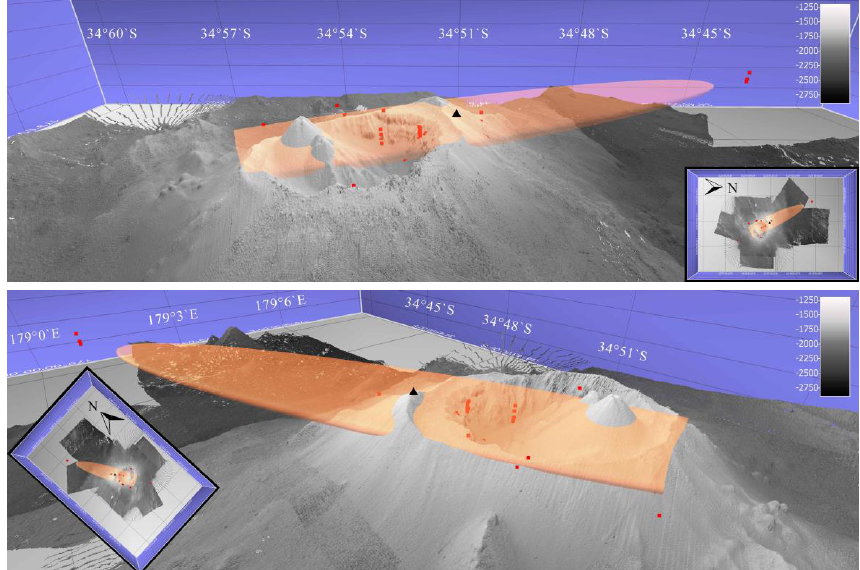
Figure A1. Local bathymetry of Brothers volcano (2-fold exaggeration) with the calculated plume ellipsoid. The two panels mark in orange color the ellipsoid based on excess 223 Ra activity above background. The red dots indicate sample locations with Ra activity above background, which were used for the ellipsoid calculation. The black triangle in each panel marks the mean latitude and longitude location of plume samples (depth not representative for display reasons), which was used as ellipsoid center. The direction of view in the first panel is westward, and northeastward in the second panel. Local bathymetry from Koschinsky et al. [53].